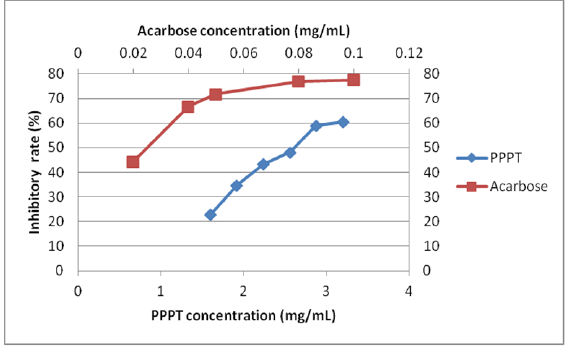
Figure 3. Inhibitory activity against α -glucosidase in vitro.